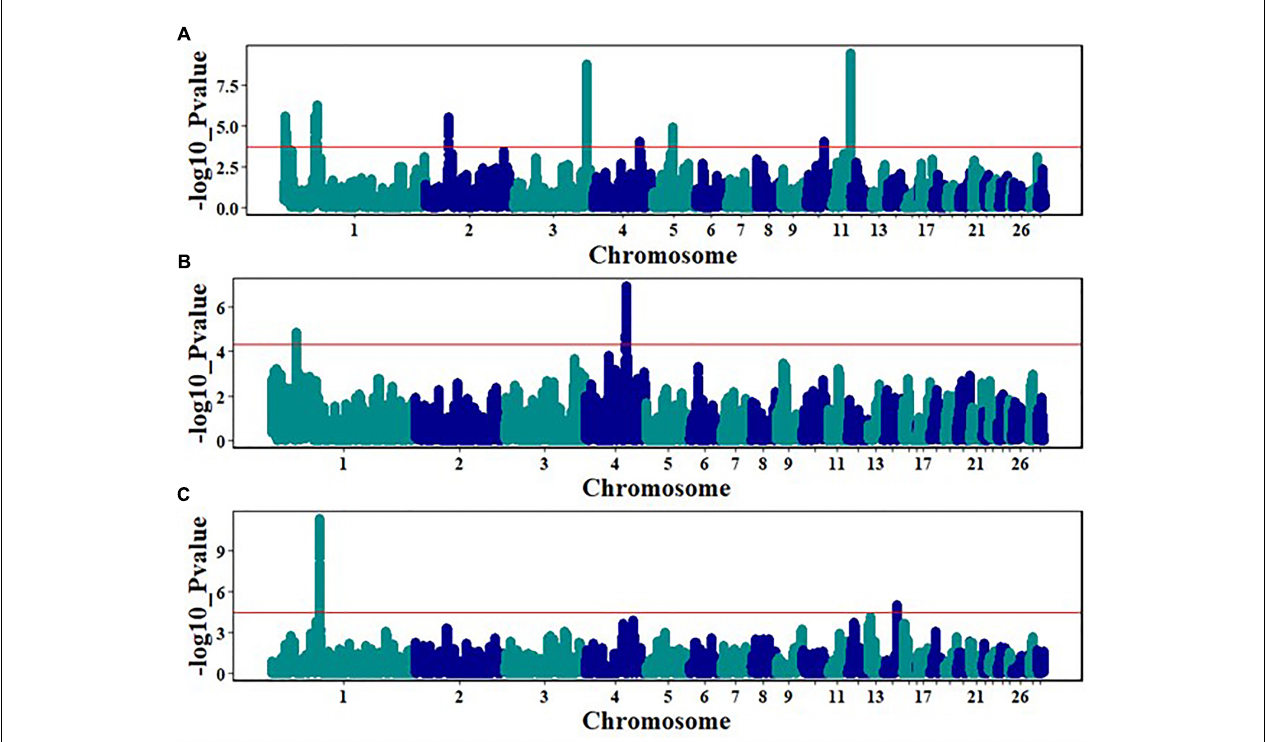
FIGURE 5 | HapFLK analysis over the entire genome across breeds/ecotypes in three country populations: red line indicates the upper 0.05% of hapFLK distribution, for (A) within Egyptian breeds/ecotype, (B) within Sri Lanka ecotypes, and (C) with Cochinchina and Brahma Brazil breeds.